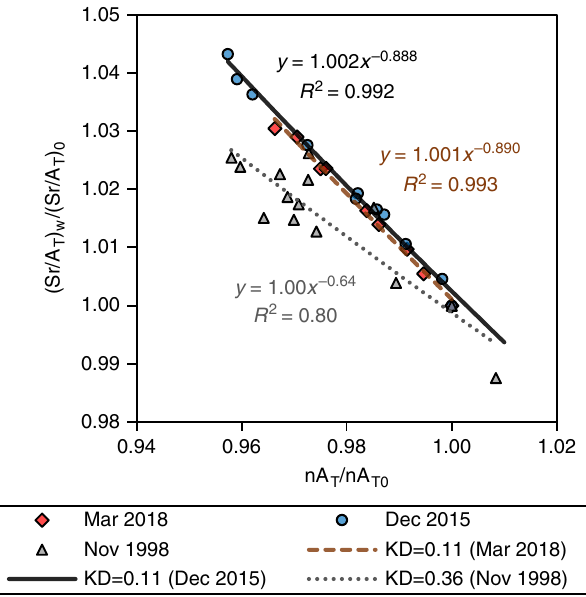
Fig. 4 Calculation of the average distribution coef fi cient of strontium in CaCO 3 precipitated along the southern and central Red Sea (Bab-el- Mandeb to 24°07 ′ N). Data collected in 1998 is from ref. 24 . Power of the trendline equals the distribution coef fi cient minus one (Eq. (1)). The average distribution coef fi cient of strontium in CaCO 3 was therefore 0.36 ± 0.16 in 1998, 0.11 ± 0.06 in 2015 and 0.11 ± 0.07 in 2018 with